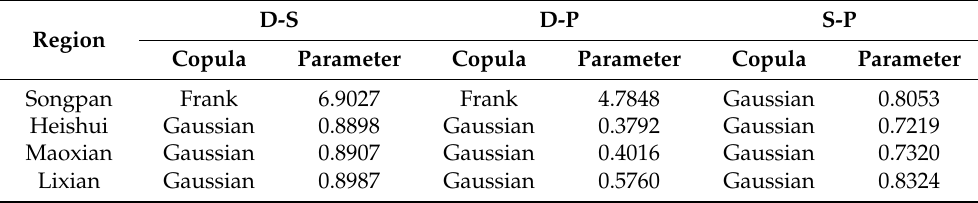
Table 7. The optimal copula function of the bivariate joint distribution of each region.